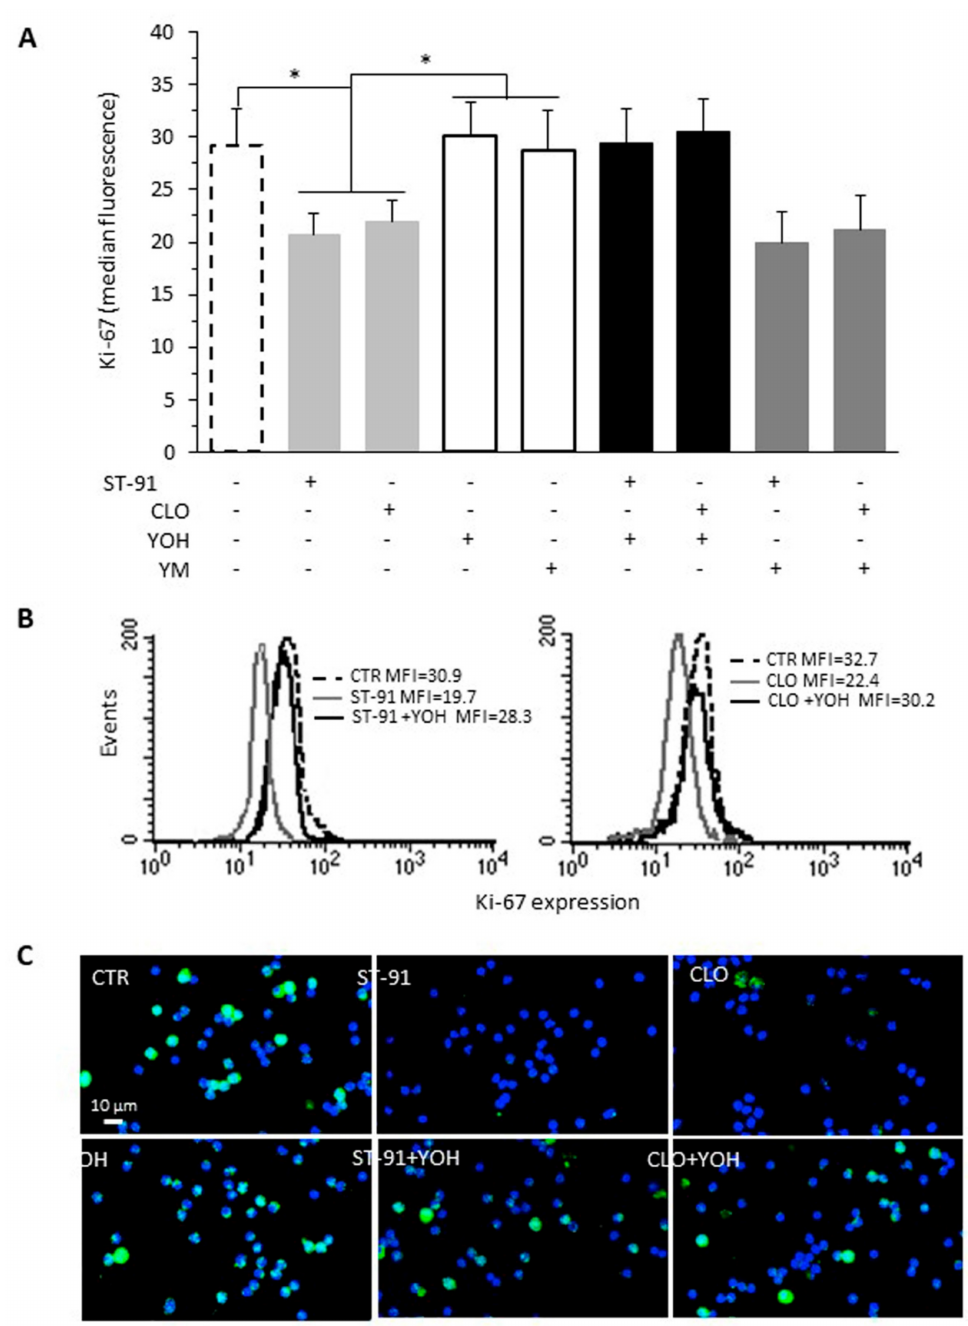
Figure 2. Effect of α 2-AR agonists on B16F10 cell proliferation. Cell proliferation was evaluated by flow cytometry measuring Ki-67 nuclear antigen expression in B16F10 cells, untreated (CTR) or treated with clonidine (CLO, 1 µ M) or ST-91 (1 µ M) alone or in combination with the α 2-AR antagonist yohimbine (YOH, 1 µ M) or with a Gq protein inhibitor YM-254890 (YM) for 48 h (left panel). ( A ) Bar graph showing the results obtained from five different experiments and expressed as mean ± SD. On the ordinate y-axis, the median fluorescence intensity values are reported. * p < 0.05. ( B ) Cytofluorimetric curves showing one representative experiment out of five. Numbers represent the median fluorescence intensity. ( C ) Representative micrographs of B16F10 cells, treated as indicated, after dual staining with an FITC-conjugated antibody against Ki-67 (green) and with Hoechst